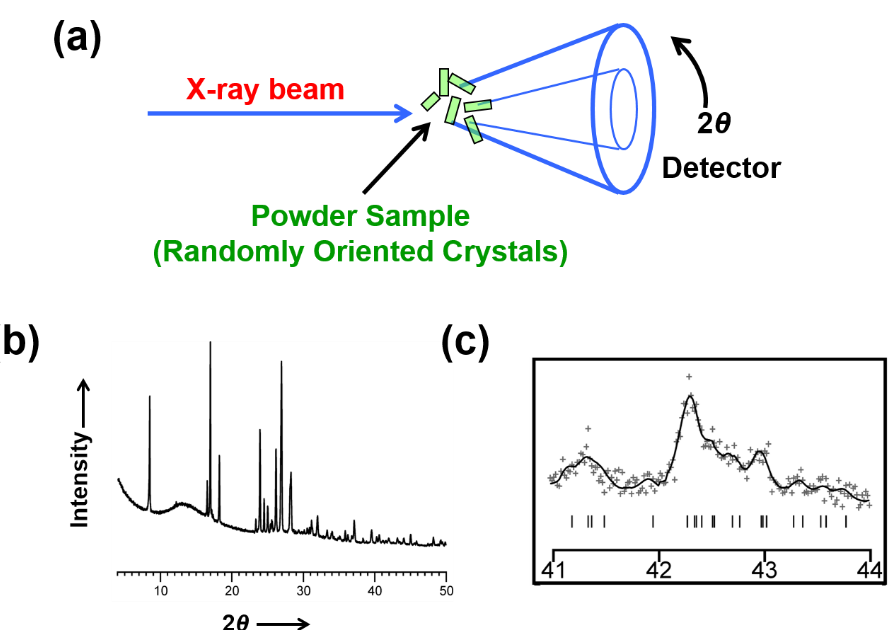
Figure 1. ( a ) Schematic representation of the experimental set-up for a powder XRD measurement. ( b ) Example of an experimental powder XRD pattern, in which the diffraction data are effectively compressed into one-dimension (i.e., scattered intensity as a function of the diffraction angle 2 θ ). ( c ) An expanded region of the powder XRD pattern illustrating significant peak overlap ( “ + ” marks are experimental data points; the solid line is the best-fit powder XRD pattern to the experimental data; tick marks indicate the 2 θ values corresponding to the positions of individual peaks).